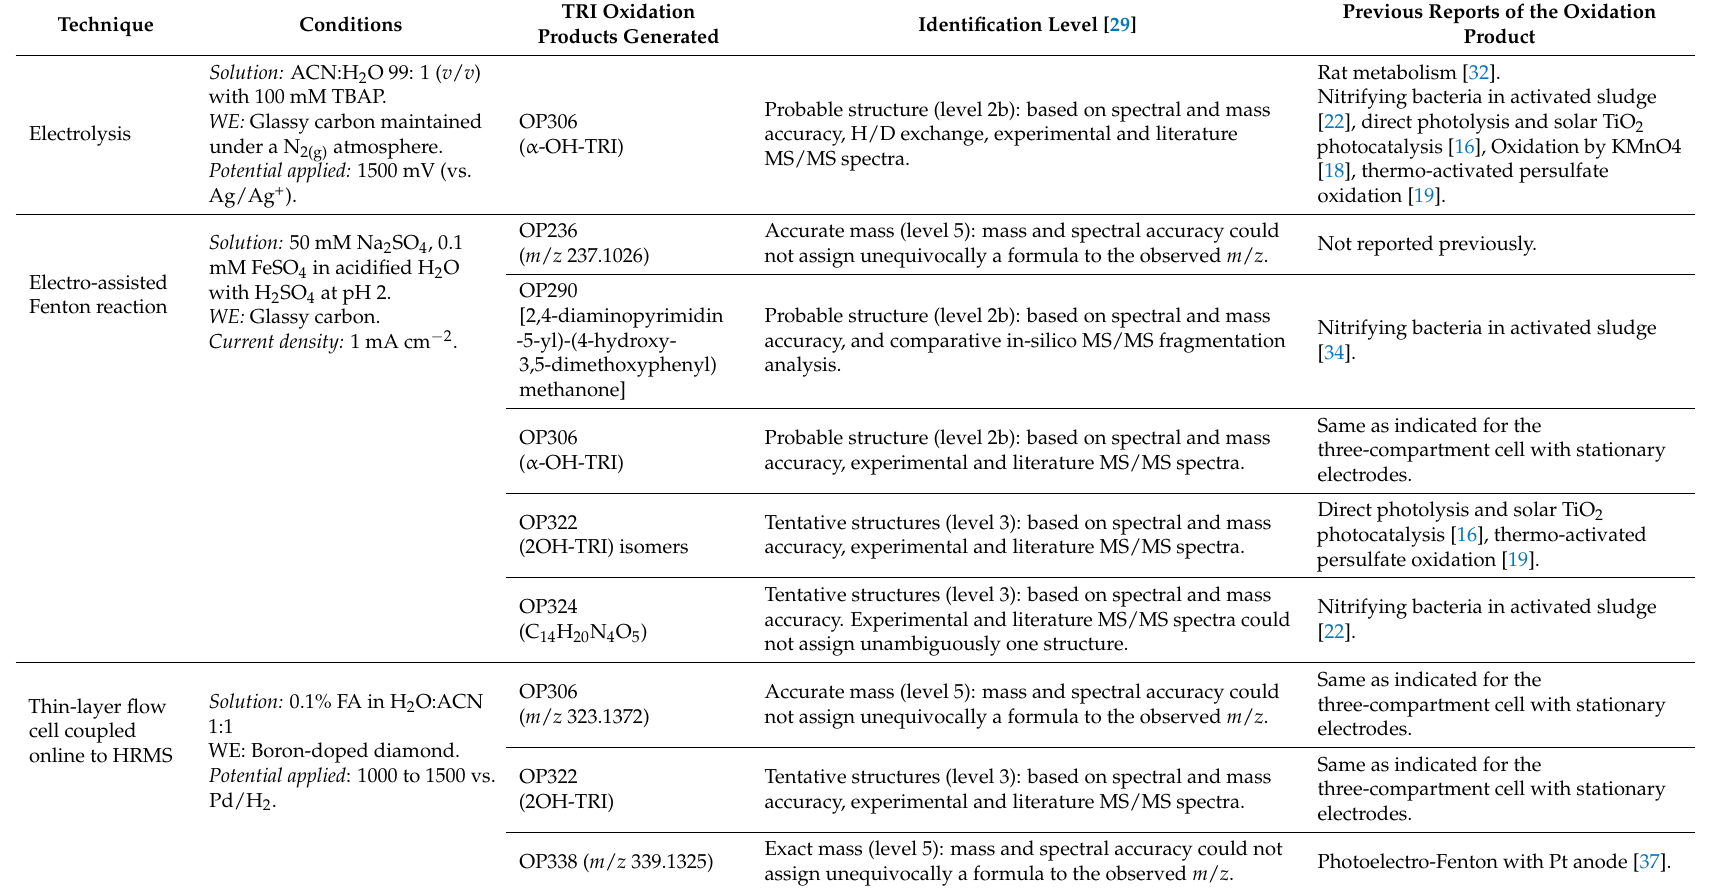
Table 3. Summary of techniques tested and the main results